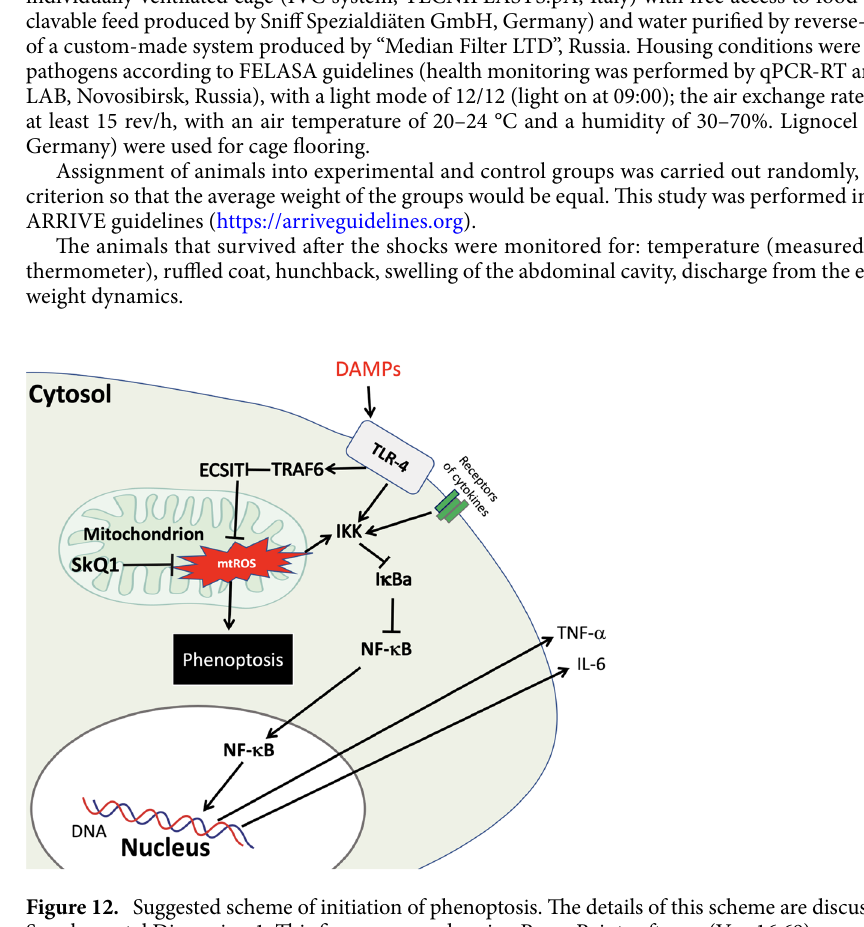
Figure 12. Suggested scheme of initiation of phenoptosis. The details of this scheme are discussed in Supplemental Discussion 1. This figure was made using PowerPoint software (Ver.